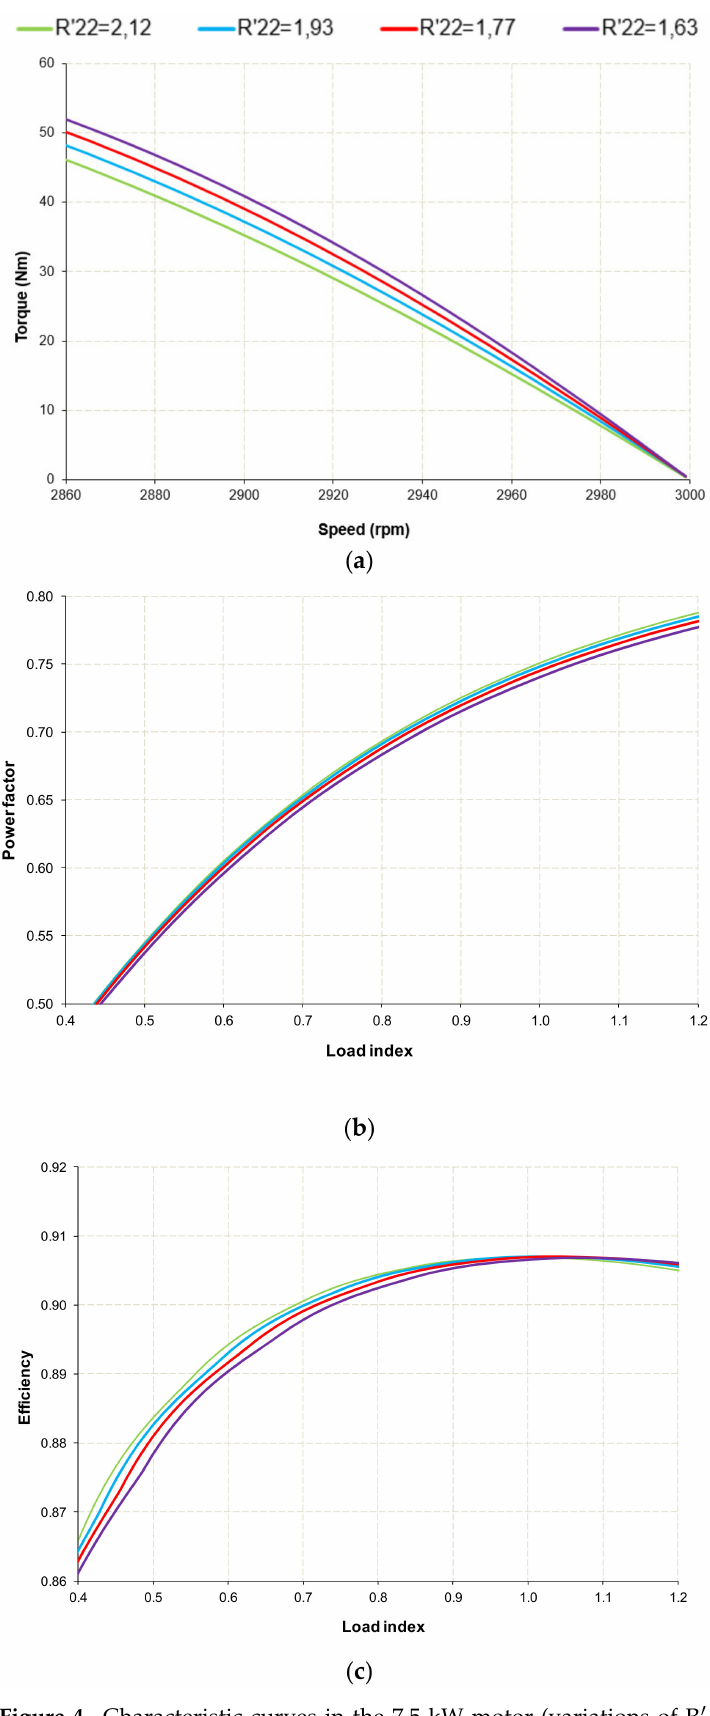
Figure 4. Characteristic curves in the 7.5 kW motor (variations of R (cid:48) 22 in Ω ). ( a ) Torque-speed (stability zone), ( b ) Power factor-load index, ( c ) Efficiency-load